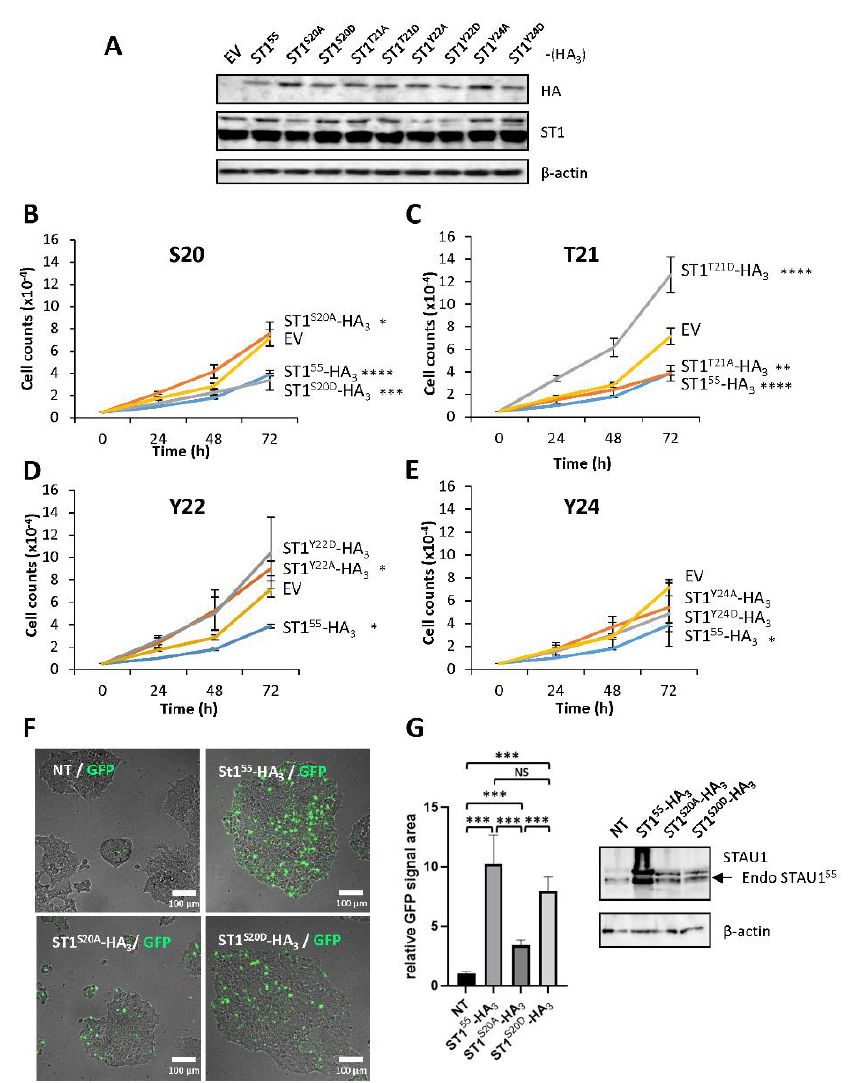
Figure 3. Serine 20 and threonine 21 controls cell proliferation and apoptosis. ( A ) HEK293T cells were transfected with plasmids coding for STAU1 55 -HA 3 or phosphomimetic (S/T/Y to D) and non- phosphorylatable (S/T/Y to A) mutants. The expression of the proteins was visualized by western blotting. The blot is representative of three independently performed experiments that gave similar results. ( B – D ) Cell proliferation using growth curve assays to monitor the effect of phosphomimetic and non-phosphorylatable mutations on serine 20 (S20) ( B ), threonine 21 (T21) ( C ), tyrosine 22 (Y22) ( D ), and tyrosine 24 (Y24) ( E ). Transfected cells were trypsinized 24 h post-transfection, plated, and allowed to grow for three days. Each graph represents the means and standard deviations of three independently performed experiments. *, p - value ≤ 0.05; **, p - value ≤ 0.01; ***, p - value ≤ 0.001; ****, p - value ≤ 0.0001 (Tukey’s multiple comparisons ANOVA test). ( F ) HEK293T cells were transfected with plasmids coding for STAU1 55 -HA 3 , STAU1 S20A -HA 3 , and STAU1 S20D -HA 3 and immediately incubated in the presence of the GFP-coupled apoptosis stain. ( G ) (Left) Quantification of the GFP signal observed in ( F ). The graph represents the means and standard deviations of three independently performed experiments. ***, p -value ≤ 0.001 (Student t -test). NT, not transfected. (Right) Western blots showing the expression of the proteins used in ( F ). The blots are representative of three independent experiments that gave similar results. Endo STAU1 55 , endogenous STAU1 55